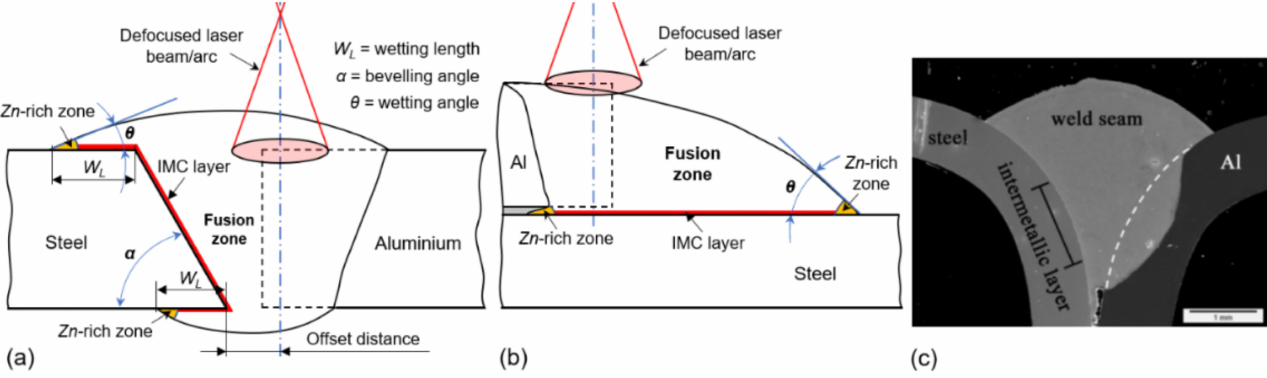
Figure 8. ( a ) Schematic illustration of typical butt joint produced by laser-assisted arc welding–brazing process, based on [41,46,47,72,81]. Laser welding–brazing of ( b ) overlap (fillet) joint, based on [45,73,82–86]; and ( c ) flanged butt or flare V-groove (fillet) joint [82]. Note, steel does not usually